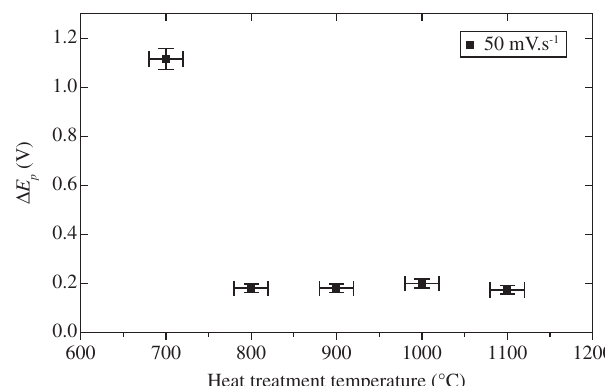
Figure 9. ∆ E as a function of HTT used in the RVC electrode manufacture, p in 1 mM Ferrocyanide/0.1 M KCl at sweep rate of 50 mV.s -1